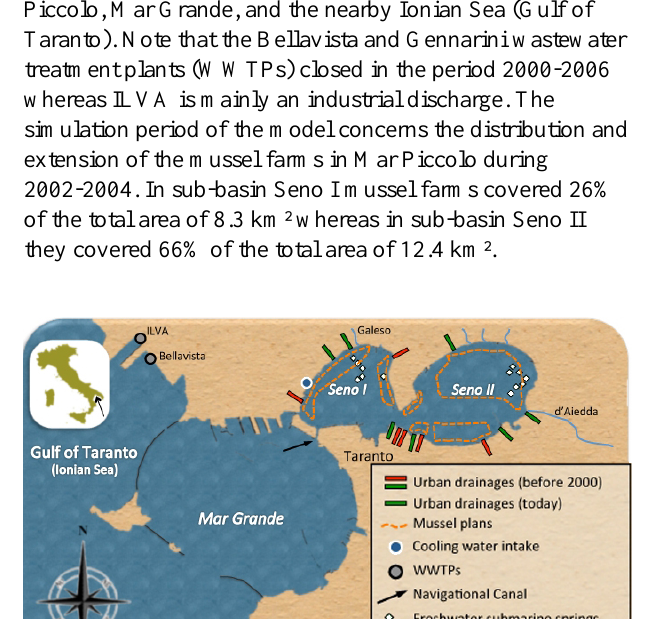
and the more deeply placed mussels, which extend only to 5